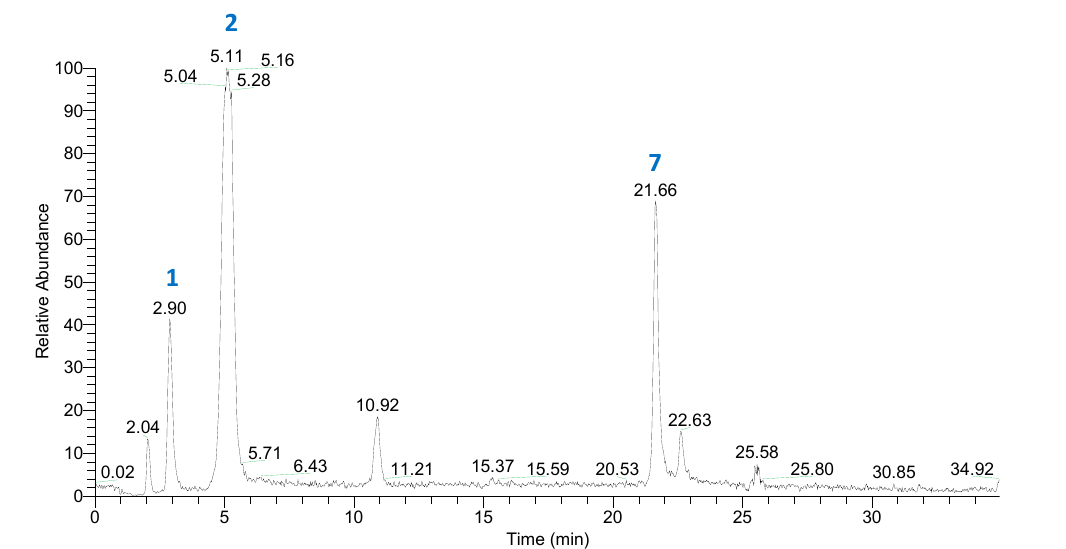
Figure 4. Total ion chromatogram (TIC) of a Qt solution (100 μ mol L − 1 ), treated at 90 °C, for 50 min, at pH 7.5. For peak assignment, see Table 2. Table 2. Mass spectral data of the major Qt degradation products, detected in Qt solutions after treatment for 50 min, at 90 ◦